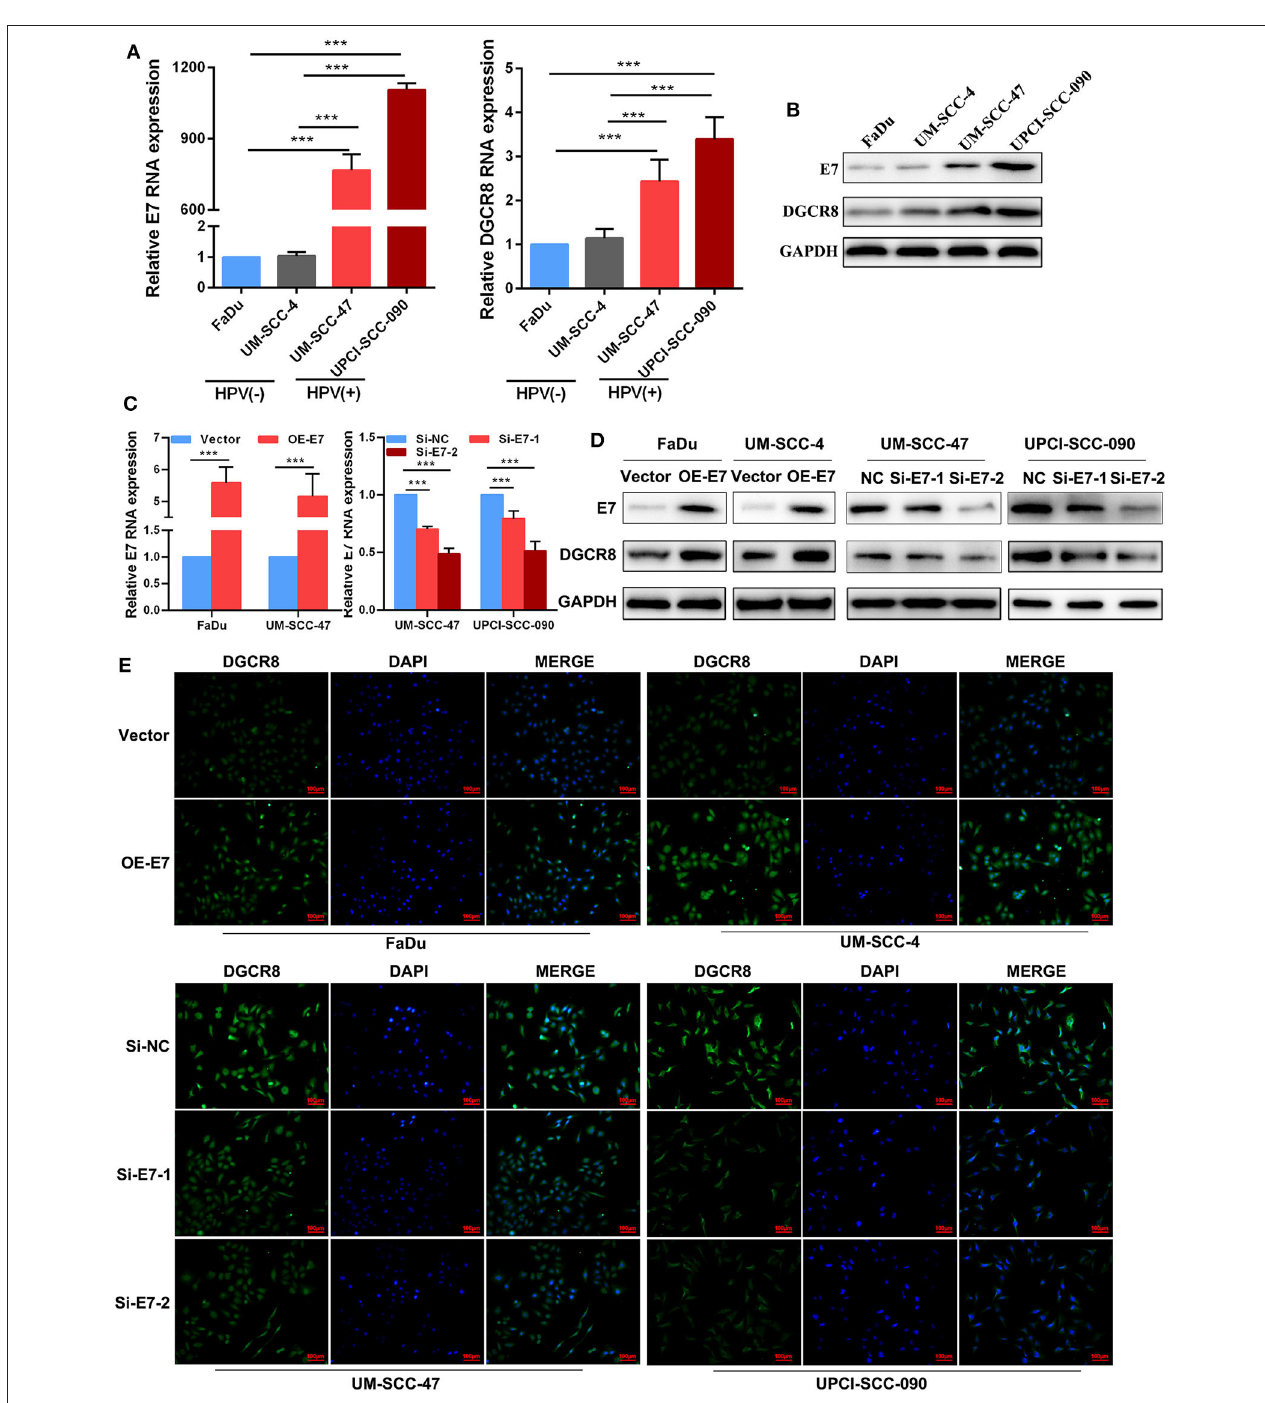
FIGURE 1 | Human papillomavirus (HPV) E7 upregulates DGCR8 expression in head and neck squamous cell carcinoma (HNSCC) cells. (A) The mRNA expressions of HPV E7 and DGCR8 in FaDu, UM-SCC-4, UM-SCC-47, and UPCI-SCC-090. (B) The protein expressions of HPV E7 and DGCR8 in FaDu, UM-SCC-4, UM-SCC-47, and UPCI-SCC-090. (C) The mRNA expression of HPV E7 in FaDu and UM-SCC-4 with E7 overexpression and UM-SCC-47 and UPCI-SCC-090 with E7 silencing. (D) The protein expressions of HPV E7 and DGCR8 in FaDu and UM-SCC-4 with E7 overexpression and UM-SCC-47 and UPCI-SCC-090 with E7 silencing. (E) HPV E7 upregulated DGCR8 expression in HPV-negative/positive cell lines by immunofluorescence. *** p < 0.001.